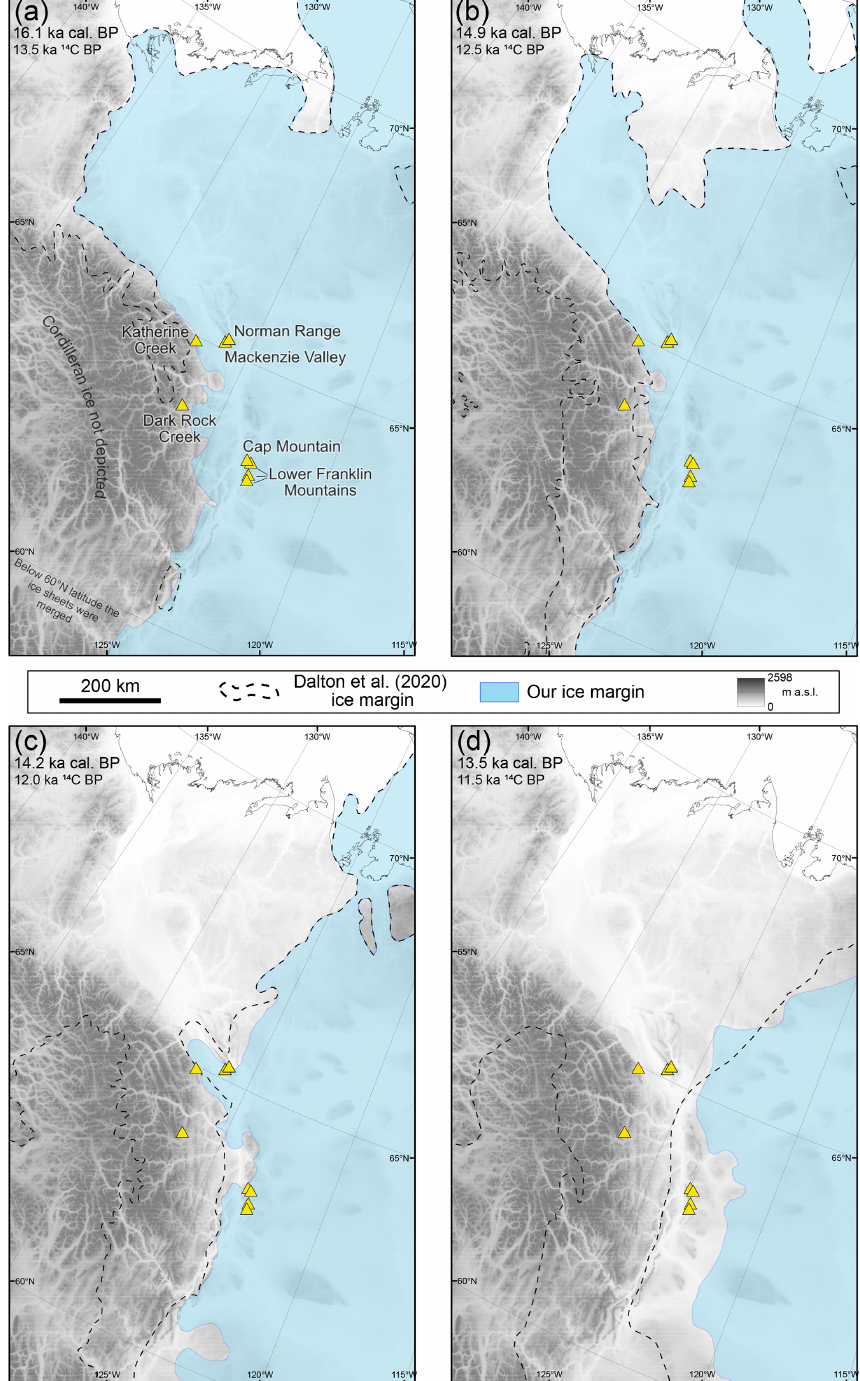
Figure 4. Our ice margin retreat chronology compared to the reconstruction of Dalton et al. (2020). Yellow triangles indicate TCN exposure sampling sites. We do not depict the Cordilleran Ice Sheet in any of our reconstructions (a) Ice margin reconstruction at 16.1kacalBP. (b) Ice margin reconstruction at 14.9kacalBP. (c) Ice margin reconstruction at 14.2kacalBP. (d) Ice margin reconstruction at